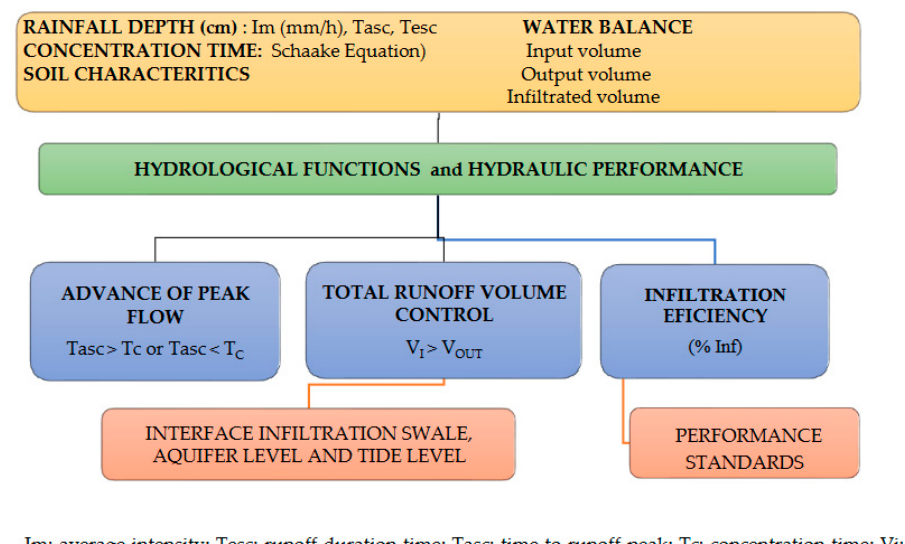
Figure 2. Data processing schema for water balance, and hydrological and hydraulic swale perfor- mance calculations.